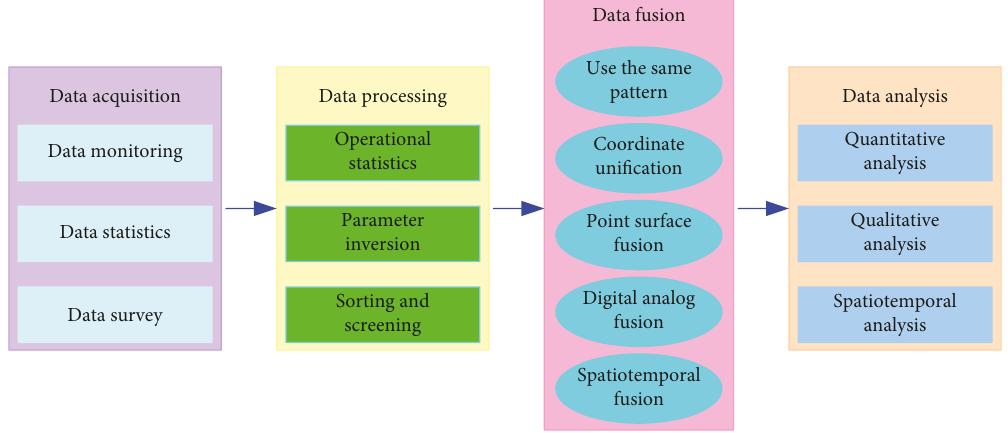
Figure 2: Schematic diagram of multi-source data fusion technology